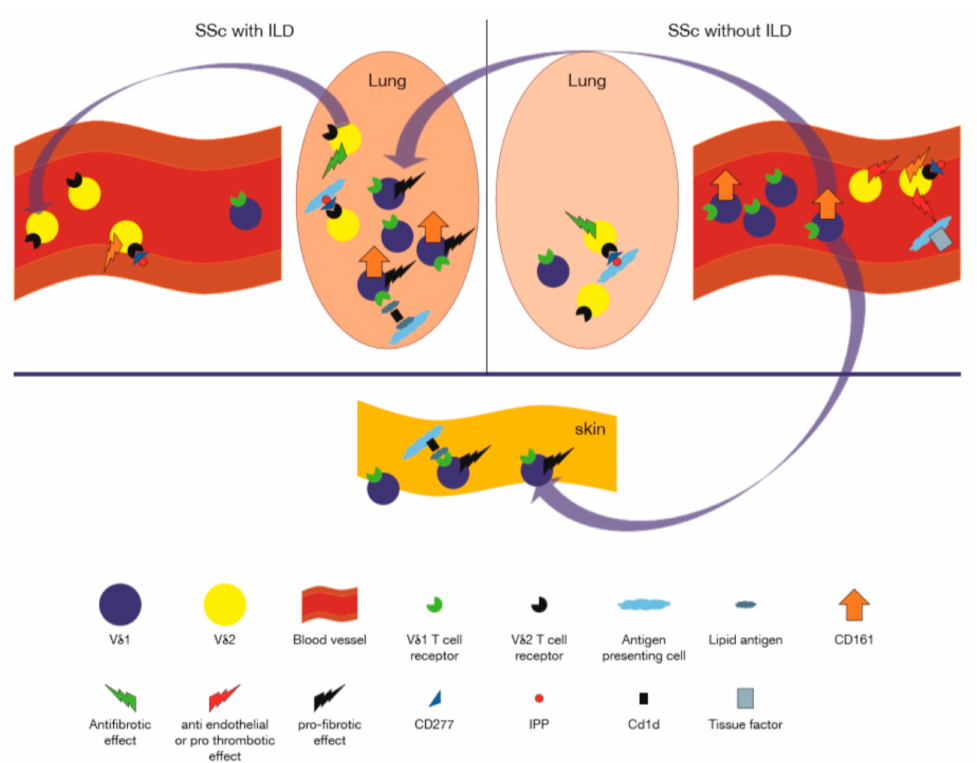
Figure 3. Role of γδ T cells in human systemic sclerosis. On the right, representing patients without interstitial lung disease, are, cytotoxic granzyme expressing V δ 2 + γδ T cells in the peripheral blood, which are shown to interact with the endothelium via engagement of the TCR with CD277 endothelial molecules activated by isopentenyl pyrophosphate (IPP), while inducing the procoagulant tissue factor on monocytes, which together could lead to endothelial damage [103,107]. The peripheral blood is enriched in CD161 + V δ 1 + T cells [104]. Profibrotic V δ 1 + cells may migrate to the lung, where they encounter cells expressing CD1d in complex with lipids, which trigger V δ 1 + T cells to secrete profibrotic factors (e.g., IL-4, CCL3) [104,105,110]. Along with this, exit of V δ 2 + T cells (which may potentially confer anti fibrotic functions), from the lung to the peripheral blood takes place [106,111]. These alterations of γδ T cell composition in the lung may contribute to progressive lung